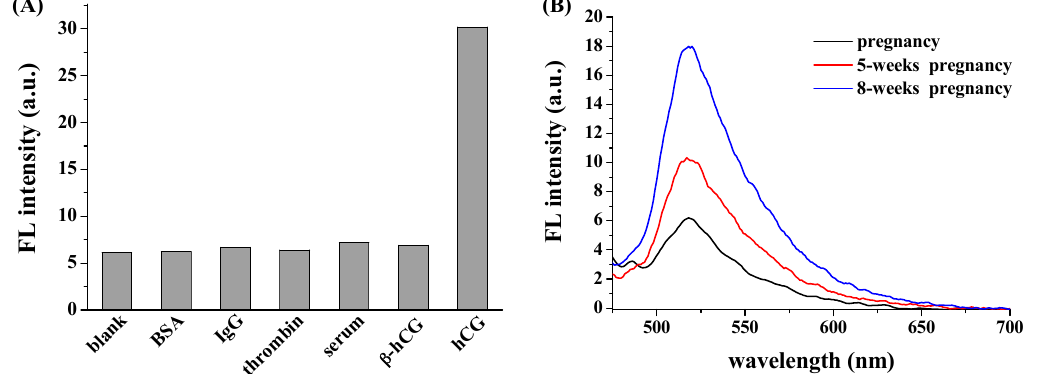
Figure 5. ( A ) Selectivity of the proposed sensing strategy. The final concentrations of BSA, IgG, thrombin, β -hCG and hCG were 10 ng/mL, 10 ng/mL, 10 ng/mL, 25 ng/mL and 10 IU/mL, respectively; ( B ) Fluorescence spectra of FITC-PPLRINRHILTR/GO for the detection of hCG in urine samples.